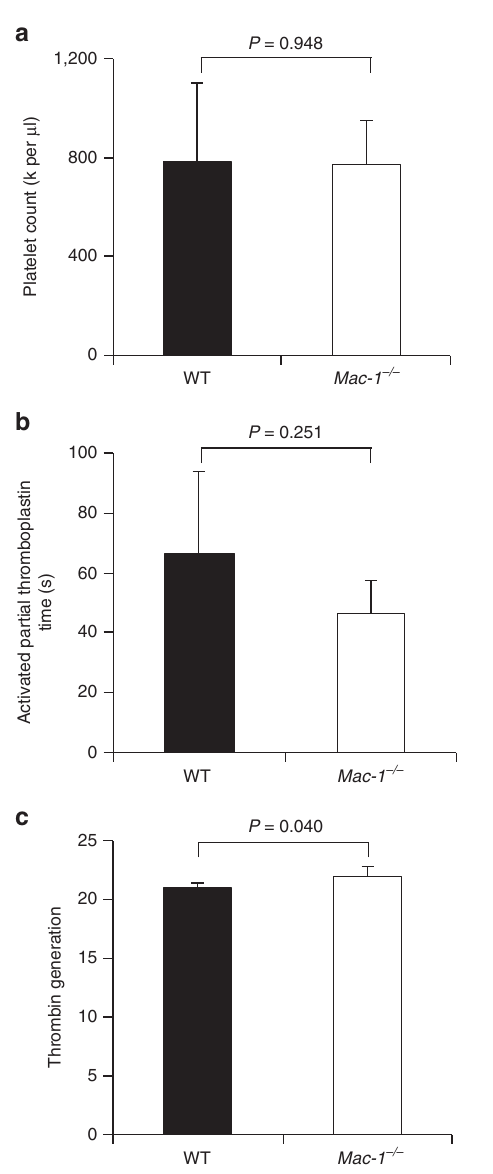
Figure 2 | Deficiency of Mac-1 has no influence on platelet count or coagulation activity. ( a ) Platelet count (10 3 m l (cid:2) 1 ) of citrate-anticoagulated mouse blood obtained from 8-week-old male WT ( n ¼ 5) or Mac-1 (cid:2) / (cid:2) mice ( n ¼ 6). ( b ) aPTT (s) in WT and Mac-1 (cid:2) / (cid:2) mice ( n ¼ 4 per group). ( c ) TF-induced thrombin generation was assayed using plasma of WT and Mac-1 (cid:2) / (cid:2) mice ( n ¼ 4 per group; mean ± s.d.). P values are obtained by unpaired two-tailed t- test. or neutrophils into Mac-1 (cid:2) / (cid:2) recipient mice before photo- chemical injury. Mac-1 (cid:2) / (cid:2) recipient mice that received 49.8 ± 17.2 min (Fig. 3a). Strikingly, the time to occlusive thrombus formation was shortened significantly in Mac-1 (cid:2) / (cid:2) recipient mice receiving WT donor PBMCs to 26.6 ± 6.9 min (Fig. 3a), nearly restoring occlusion time to that observed in WT mice (21.7 ± 6.4 min; Fig. 1a). We also performed adoptive transfer of WT or Mac-1 (cid:2) / (cid:2) neutrophils isolated by density gradient centrifugation into Mac-1 (cid:2) / (cid:2) recipient mice. Mac-1 (cid:2) / (cid:2) mice that received Mac-1 (cid:2) / (cid:2) donor neutrophils formed occlusive thrombi in 57.2 ± 18.7 min. The time to occlusive thrombus formation